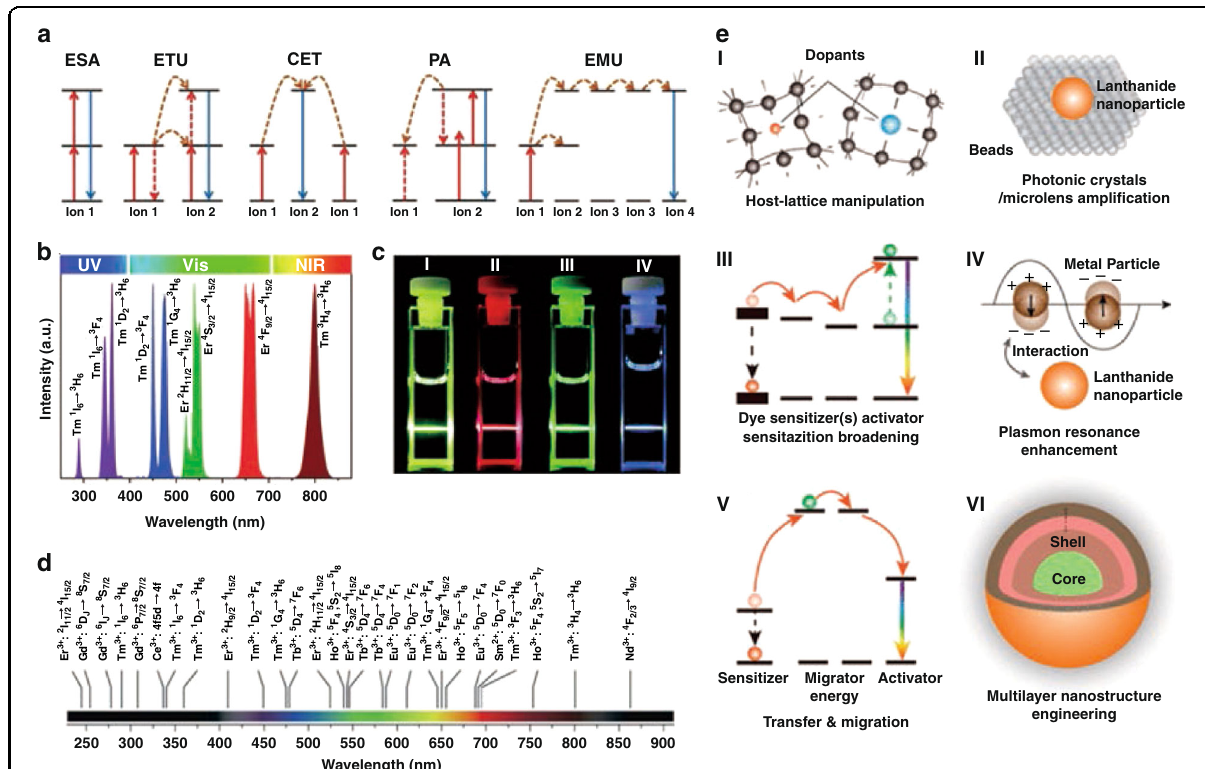
Fig. 1 Upconversion processes and optical modulation. a Schematic diagrams of fi ve upconversion processes 4 . b Representative UCL emissions of UCNPs doped with Yb – Er and Yb – Tm ranging from UV to NIR region under irradiation at 980 nm. c Photographs of UCL of UCNPs in colloidal solution. (I) Total UCL of NaYF 4 :Yb,Er sample. (II, III) The UCL of NaYF 4 :Yb,Er sample through red and green fi lters, respectively. (IV) Total UCL of NaYF 4 : Yb,Tm sample 3 . d By selecting the proper type of doping Ln 3 + within UCNPs, a broad range of emission wavelengths from UV to NIR spectral region that could be modulated 5 . e Several photoluminescence enhancement strategies in Ln 3 + -doped UCNPs. (I) host lattice modulation, (II) photonic crystal and microlens magni fi cation, (III) molecular sensitization, (IV) plasmon resonance enhancement, (V) energy transfer/transfer manipulation,